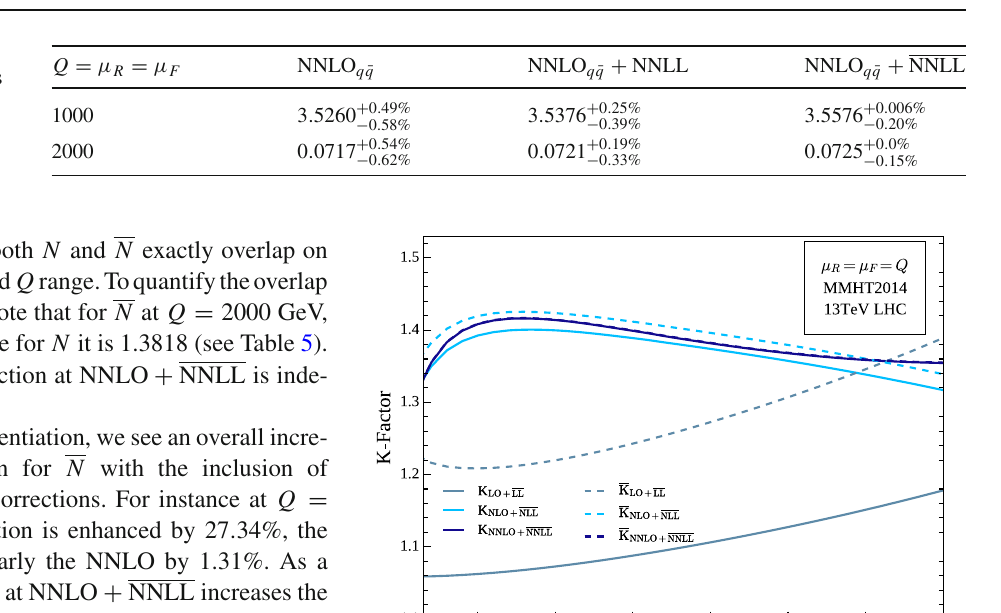
for different logarithmic accuracies. Noting various